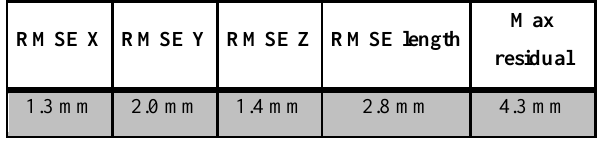
Table 1. Statistics resulting from the rigid transformation/coarse alignment.